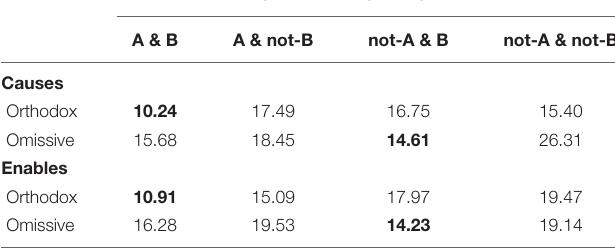
TABLE 3 | Mean latencies (in s) to construct each of four separate possibilities in Experiment 3 as a function the causal relation (causes vs. enables) in each trial and as a function of whether the premise described an omissive or an orthodox